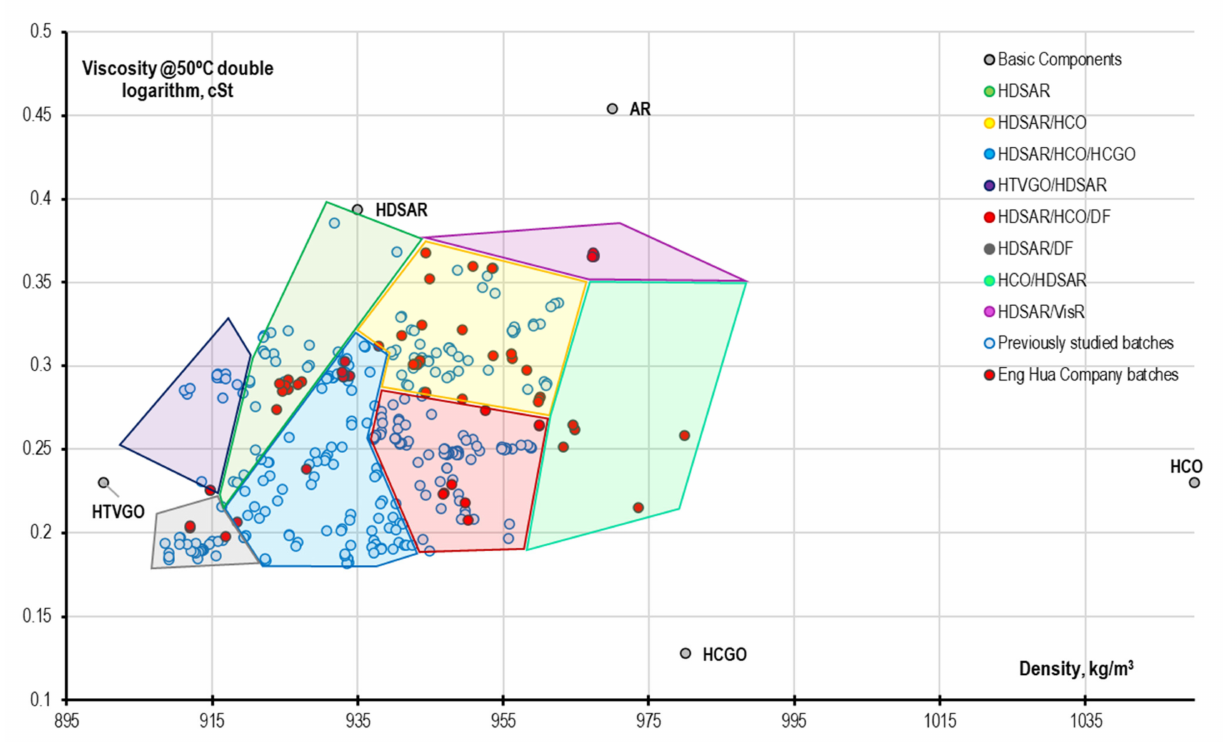
Figure 14. Eng Hua Company batches in logarithmic coordinates